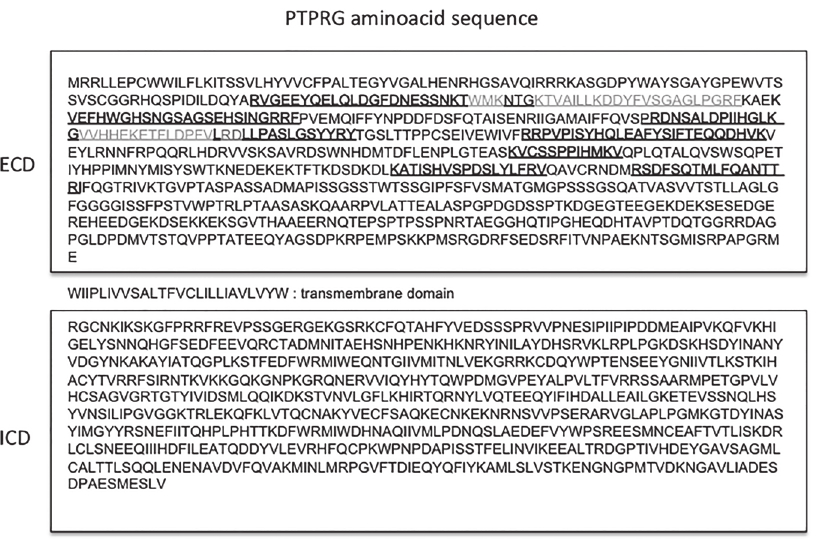
Fig 2. Localization of PTPRG-derived peptides. Schematic representation of peptides identified by large- scale proteome analysis and reported in the literature[20 – 22]. In grey are the sequences found in all the studies. ECD: extracellular domain, ICD: intracellular